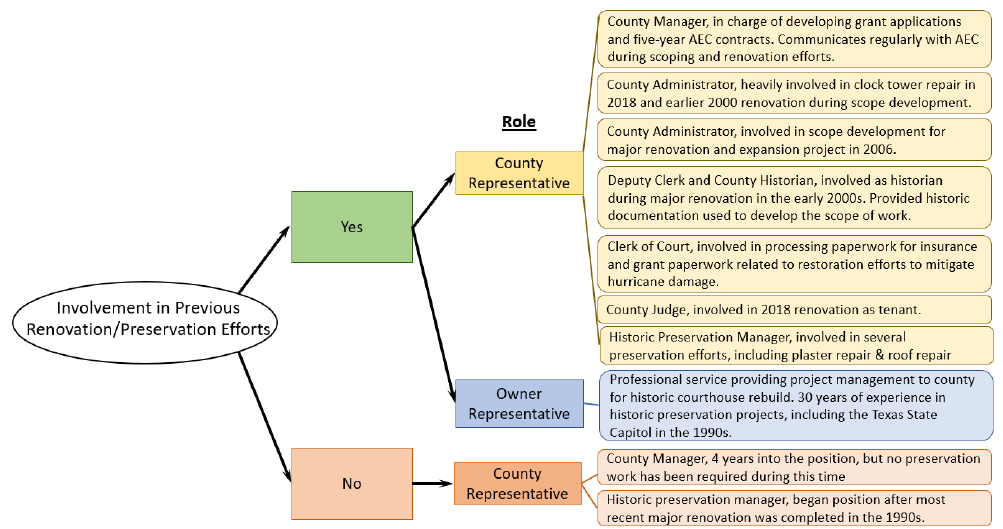
Figure 13. Results to interview question #3: involvement in previous renovation/preservation ef ‐ forts.